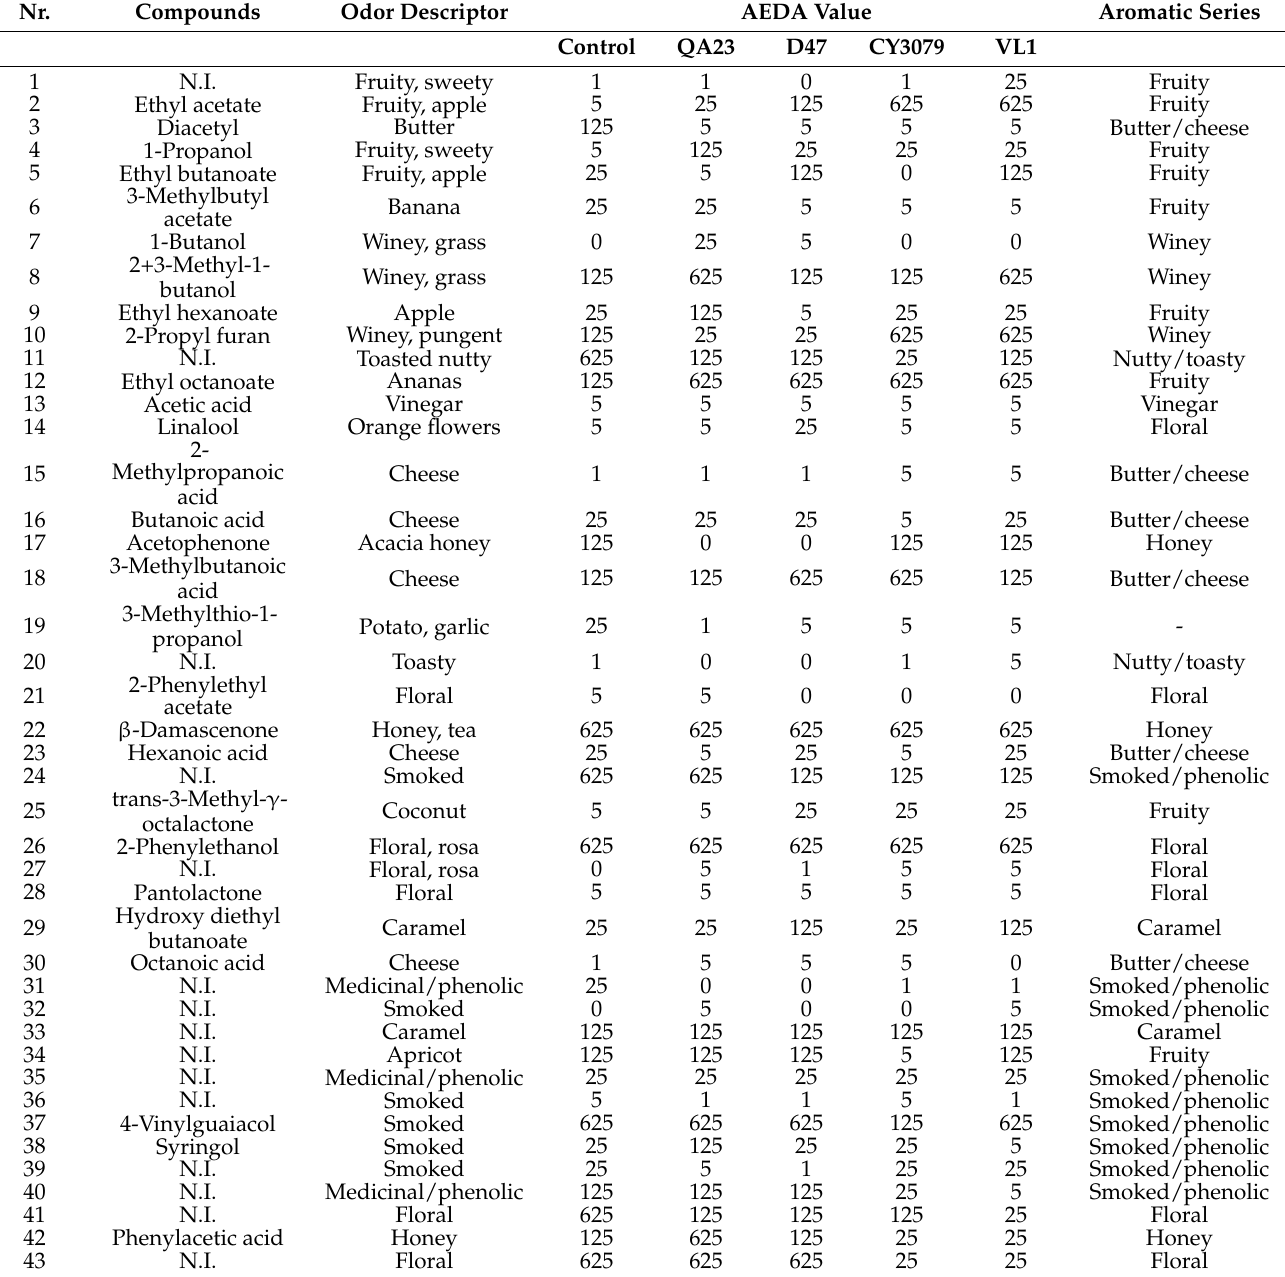
Table 2. Results of olfactometric analysis of white wines cv. “Fiano” fermented in oat barrels using four different yeast strains, three S. cerevisiae and one S. bayanus , compared to the control without yeast inoculation.